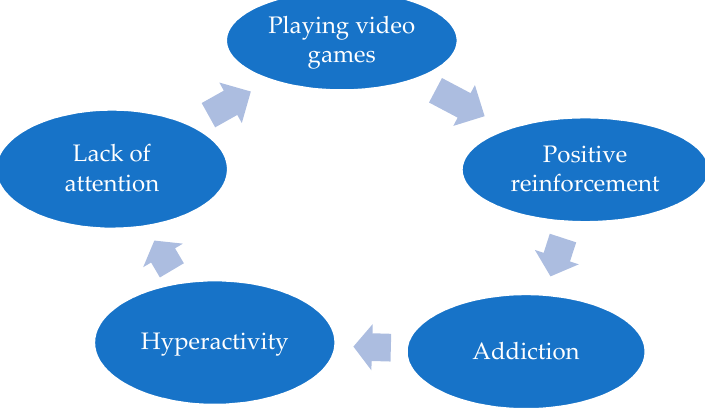
Figure 2. The cyclical process of ADHD and video games use